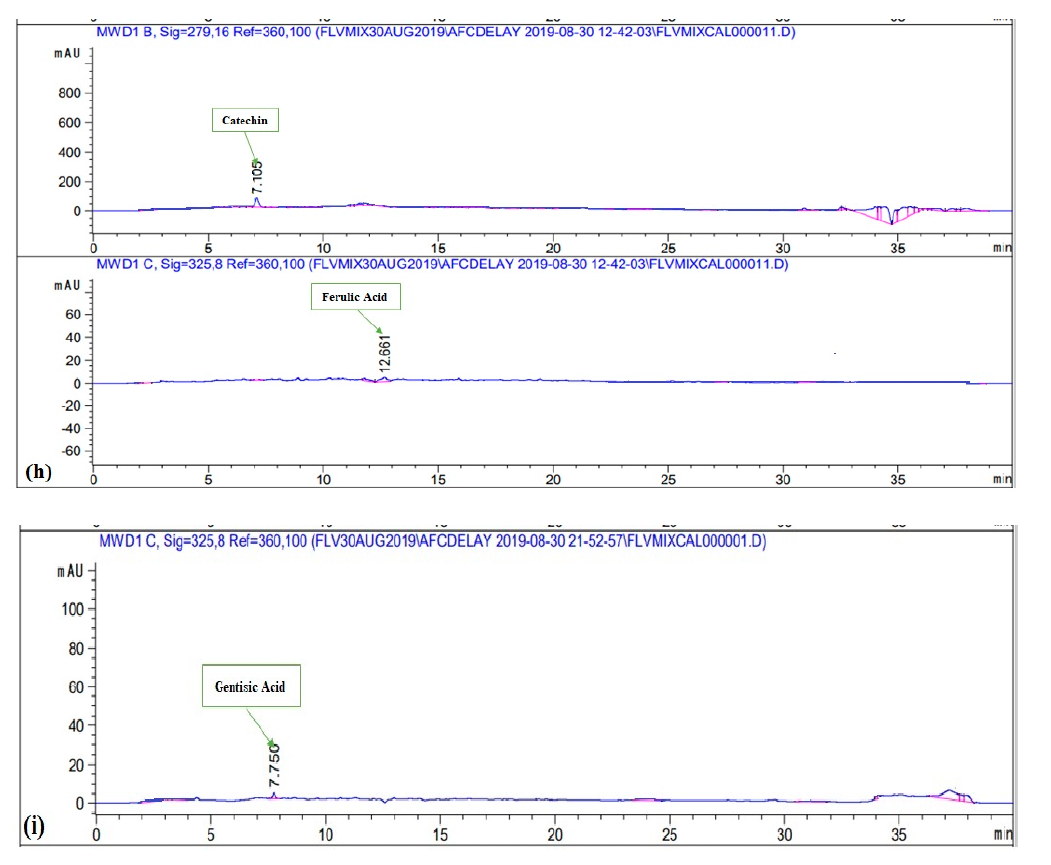
Figure 2. HPLC chromatograms of ( a ) standard polyphenols ( b ) EA-S ( c ) MeOH-S ( d ) DW-S ( e ) Table 1. Chemical profiling ( µ g/mg extract) of stem, leaf and fruit parts of P. roxburghii using